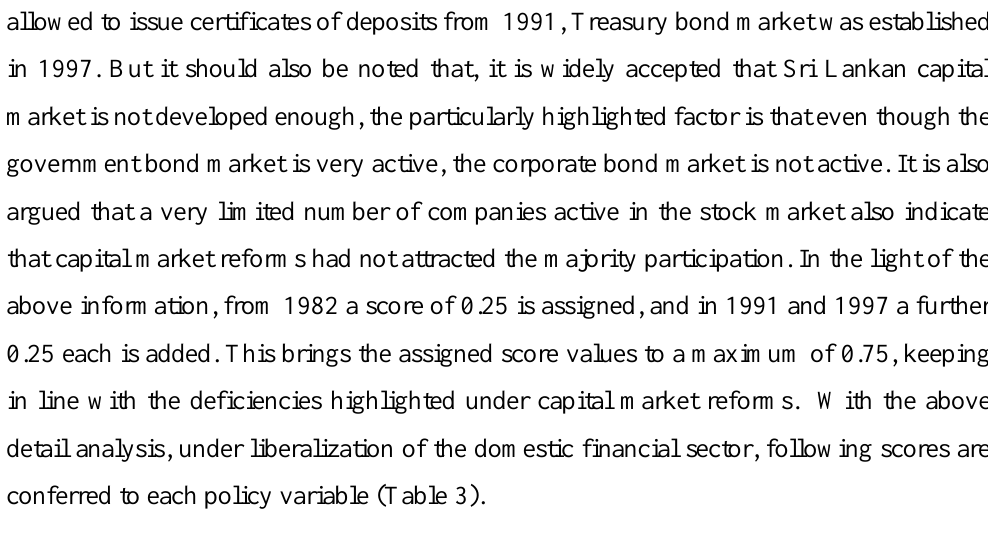
Table 3: Liberalization of the Domestic financial Sector – Scores assigned